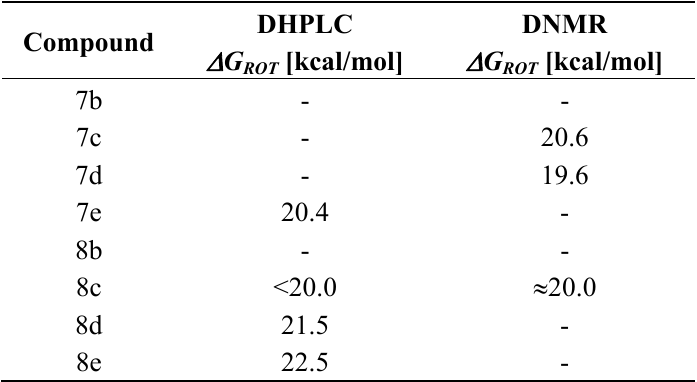
Table 3. Barrier of atropisomerization of 7 and 8